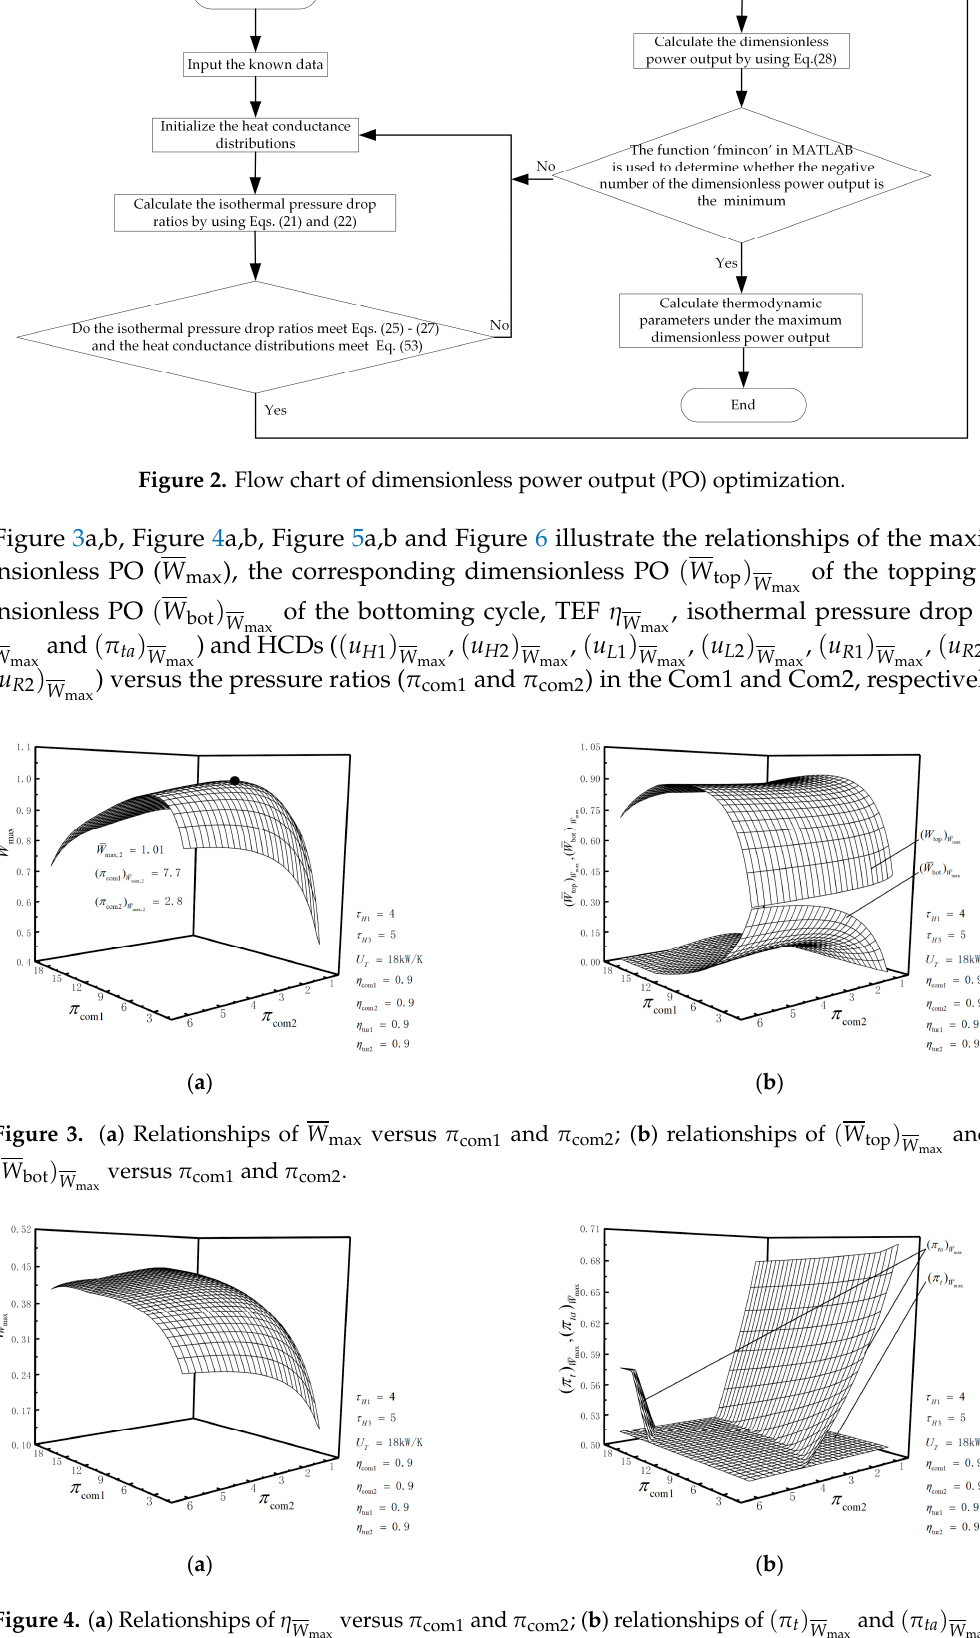
and ( π ta ) W max W max